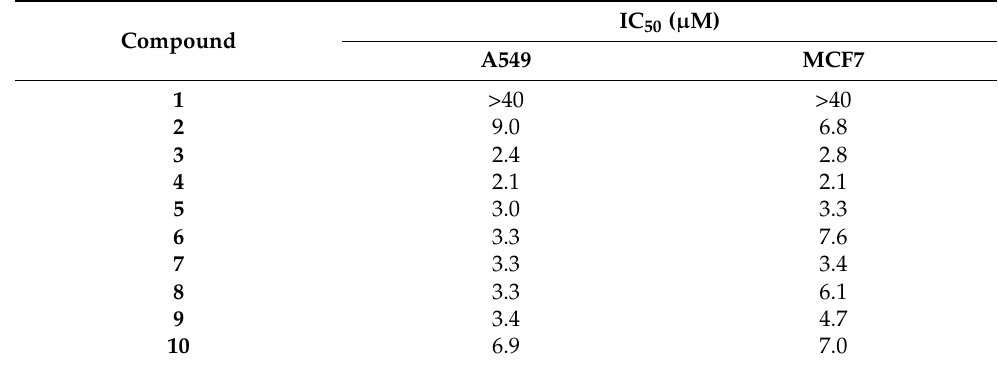
Table 10. The in vitro cytotoxicity of glycyrrhetinic acid conjugates with amide linkages in the C-3 position against cancer cell lines. ( 1 ) Glycyrrhetinic acid; ( 2 ) cisplatin; ( 3 ) glycyrrhetinic acid-L- glycine; ( 4 ) glycyrrhetinic acid-L-alanine; ( 5 ) glycyrrhetinic acid-L-phenylalanine; ( 6 ) glycyrrhetinic